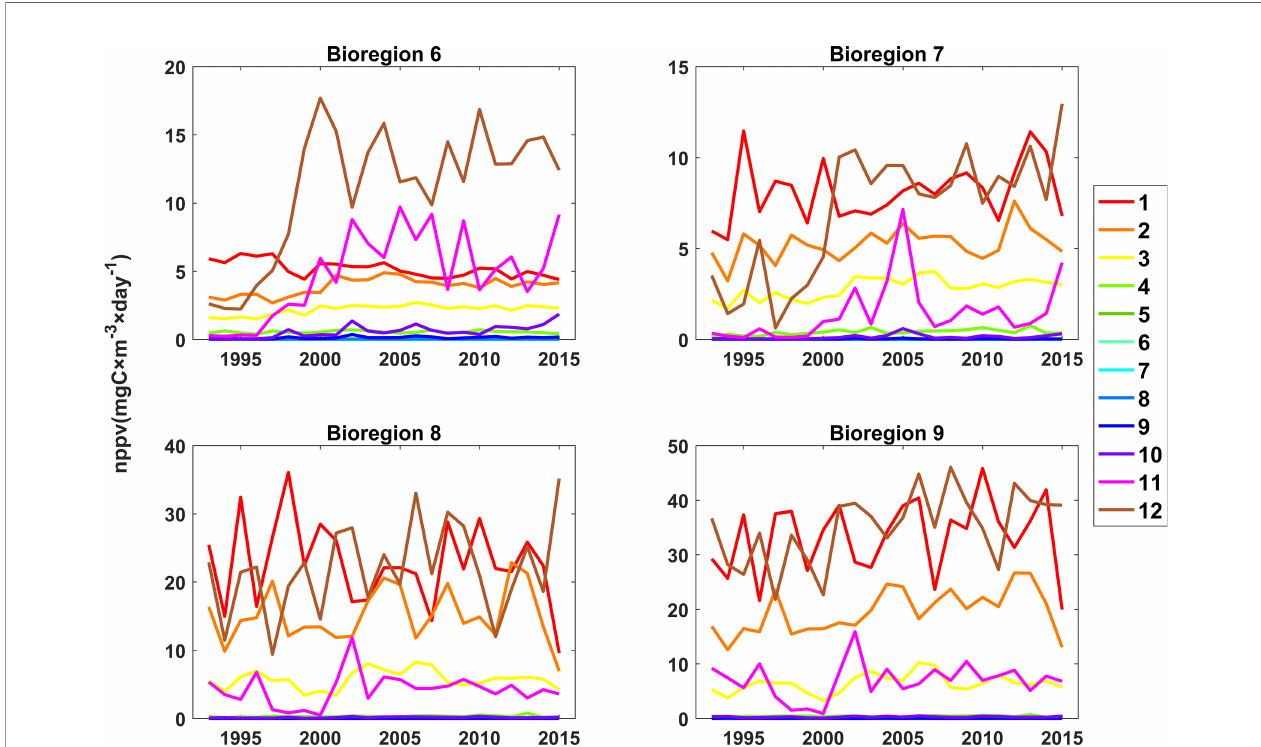
FIGURE 8 | Changes in monthly net primary productivity values in bioregions 6, 7, 8, and 9 from 1993 to 2015 (the colors represent different